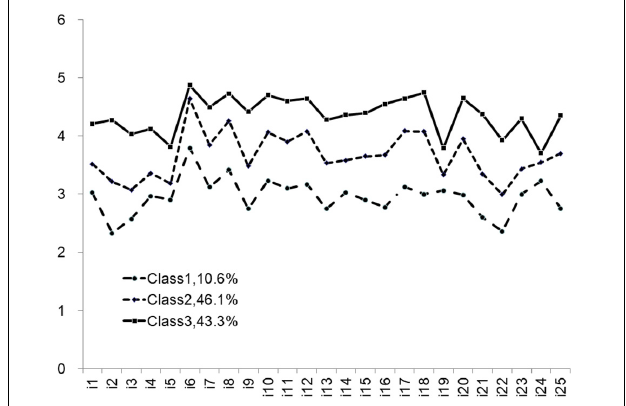
FIGURE 1 | Mean scores of the three latent classes for each of the 25 items of the Rural Left-behind Children’s Psychological Capital